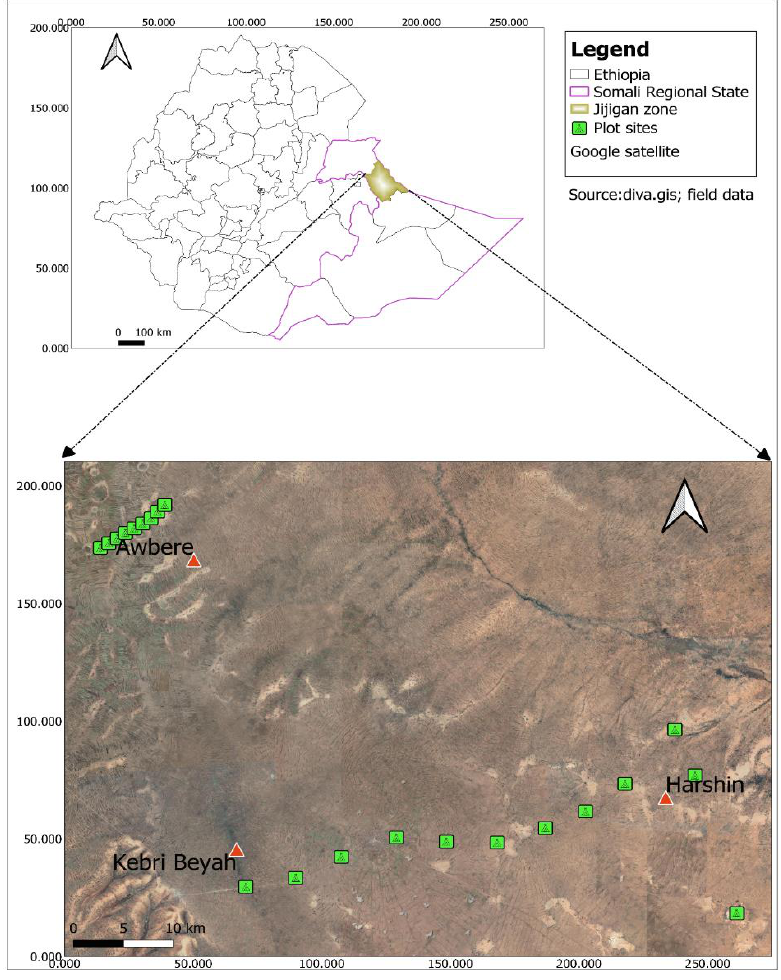
Figure 1. Location of the study area.